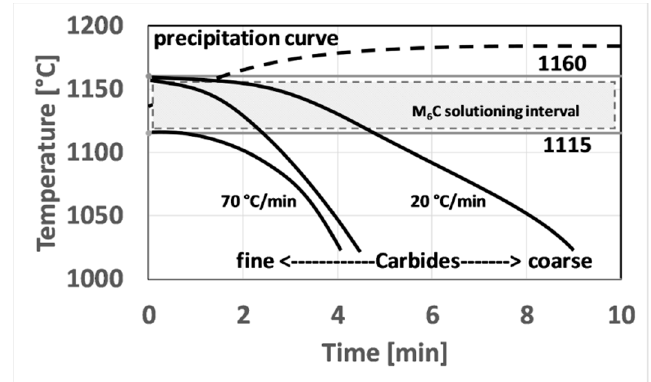
Figure 16. Schematic showing how solutioning temperature and cooling rate affects carbides dimension.